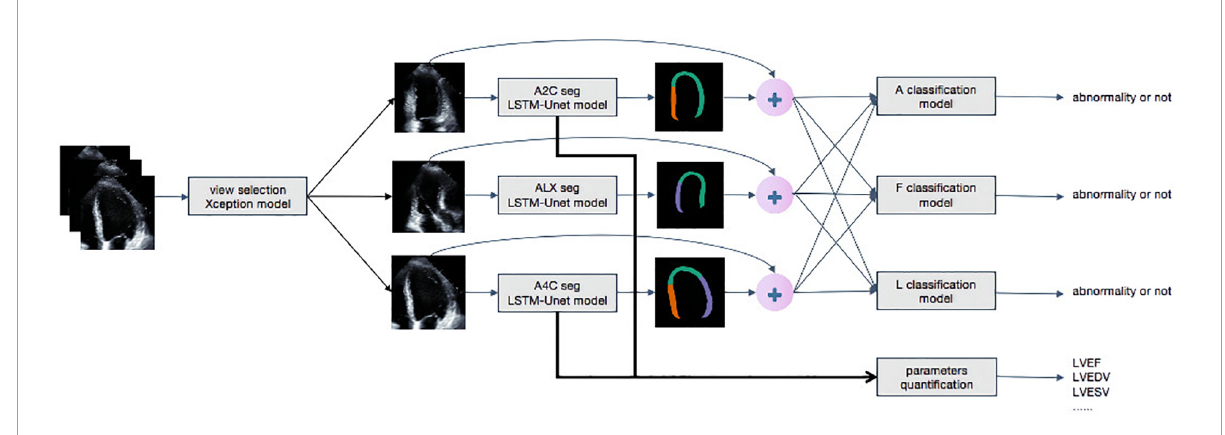
FIGURE3 The whole work flow of deep learning model. Steps of data processing. The first model achieves view selection on echocardiography. The Xception model generates a confidence level for view selection and selects A4C, A2C, and ALX views whose confidence is higher than 0.9. Secondly, LSTM-Unet segments each frames of outputs of Xception. The segment and the original video are concatenated as inputs of classification models to detect regional wall motion abnormality. The outputs of LSTM-Unet with A4C and A2C are calculated important parameters, such as LVEDV, LVESV, and